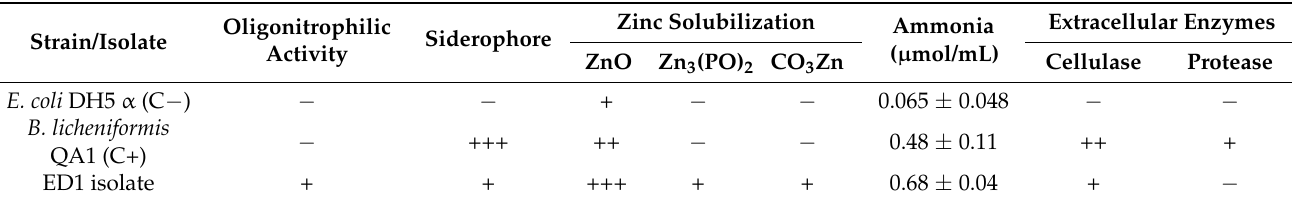
Table 1. Summary of relevant plant growth promoting (PGP) traits of the ED1 isolate, the PGPR strain Bacillus licheniformis QA1, and E. coli DH5 α (C −